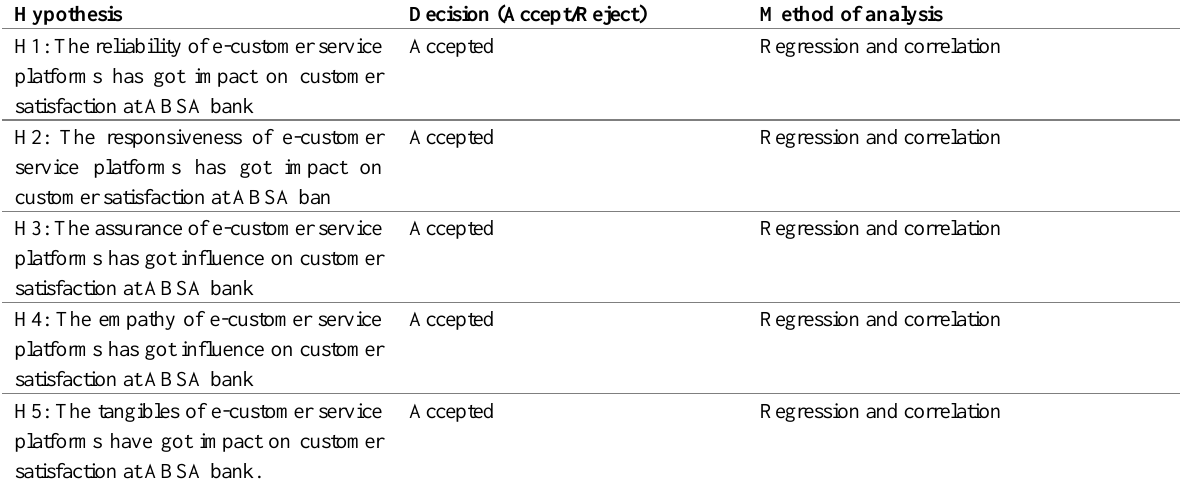
Table 18: Table Showing Hypothesis Tested in The